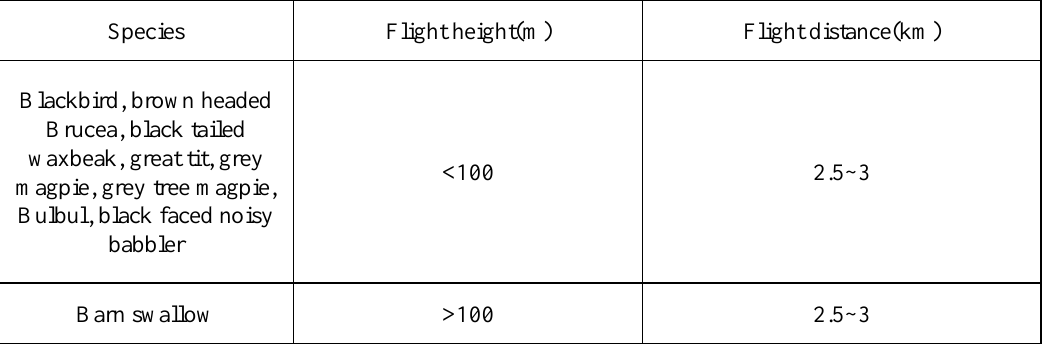
Table 1.Flight height and distance of